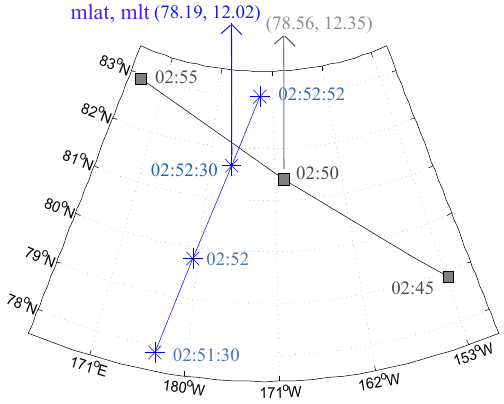
Figure 12. Satellite footprints in geographical coordinates for 9 June 2008: blue star is for CHAMP, grey square is for Cluster 3. Colours of times in the plot correspond to the colours of satellite footprints. Arrows point to magnetic latitude and magnetic local time for satellites in conjunction.